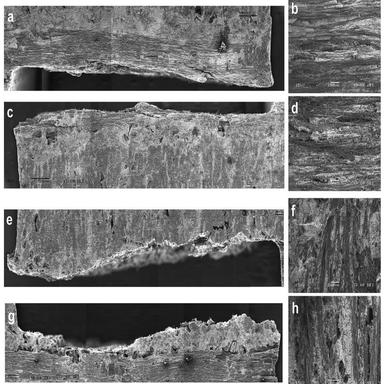
Low magnification SEM images of Cf-HfB2 powder composites after interlaminar shear testing. (a) Strongest sample; part 1 cross-section, (b) strongest sample; part 1 fracture surface, (c) strongest sample; part 2 cross-section, (d) strongest sample; part 2 fracture surface,(e) weakest sample; part 1 cross-section, (f) weakest sample; part 1 fracture surface, (g) weakest sample; part 2 crosssection, (h) weakest sample; part 2 fracture surface.